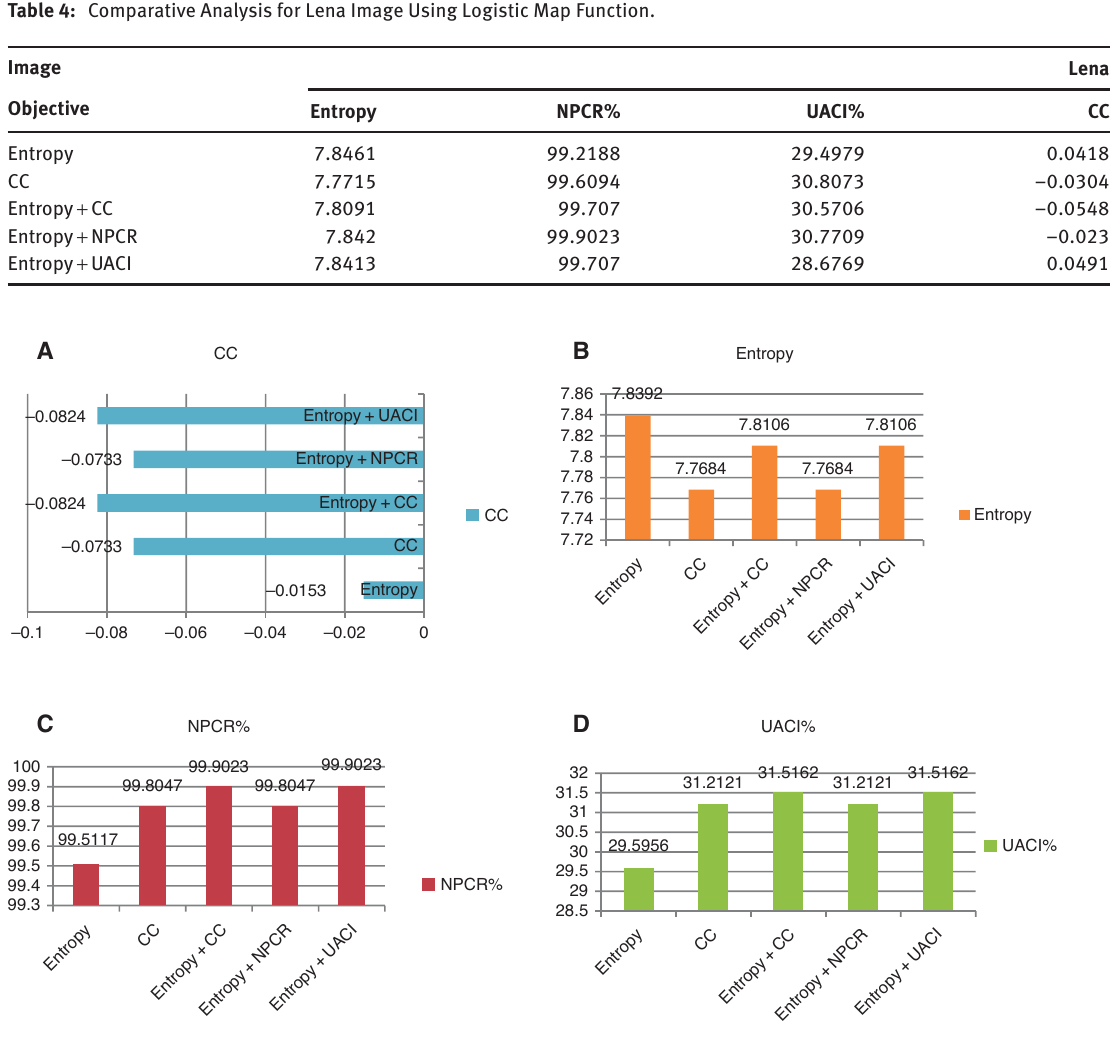
Figure 4: Comparative Analysis for Camera_man Image Using Logistic Map